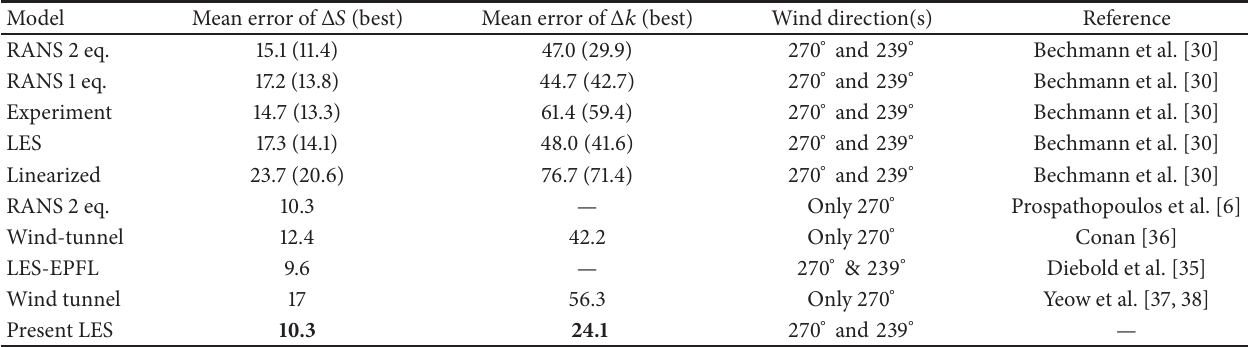
Table 1: Mean absolute errors of speedup and TKE increase from the literature and in the present LES. The values in brackets show the best performance of the particular model